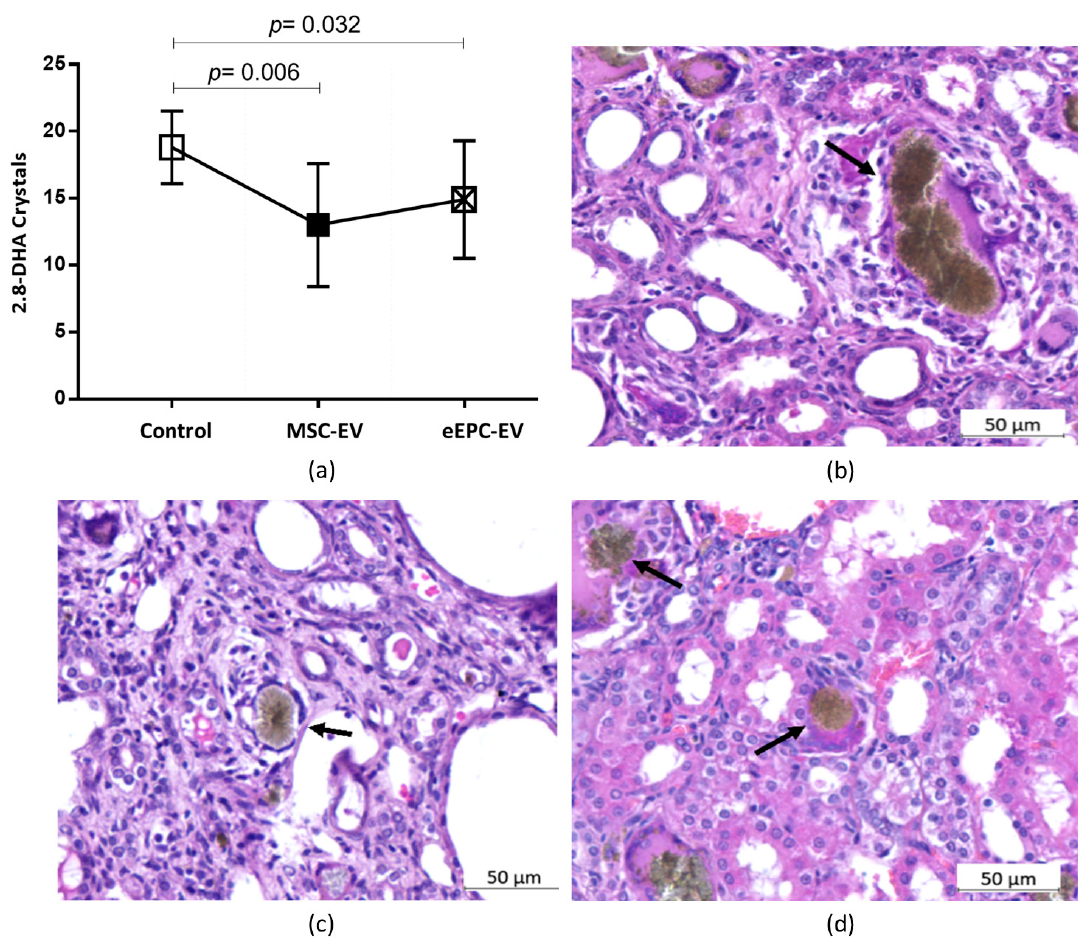
Figure 6. ( a ) Number of crystals present in renal tubules. There was a significant difference in the amount of crystal deposition between the groups ( p = 0.014) and when comparing group C with the MSC-EV group ( p = 0.006) and group C with the eEPC-EV group ( p = 0.032). The data in the figure are the mean ± sd. p < 0.05 is considered significant. ( b – d ) Histopathological evaluation of the kidneys. H&E staining. Different dimensions of the crystals (arrows). The dimensions of the crystals in ( b ) (Group C) were more extensive than those observed in ( c , d ) (groups MSC-EV and eEPC-EV, respectively).